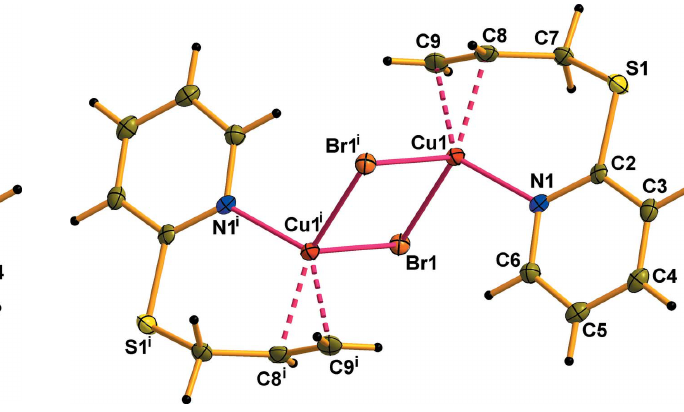
Figure 2 The molecular structure of II with displacement ellipsoids drawn at the 50% probability level. Symmetry code: (i) (cid:3) x + 1, (cid:3) y + 1, (cid:3) z + 1.